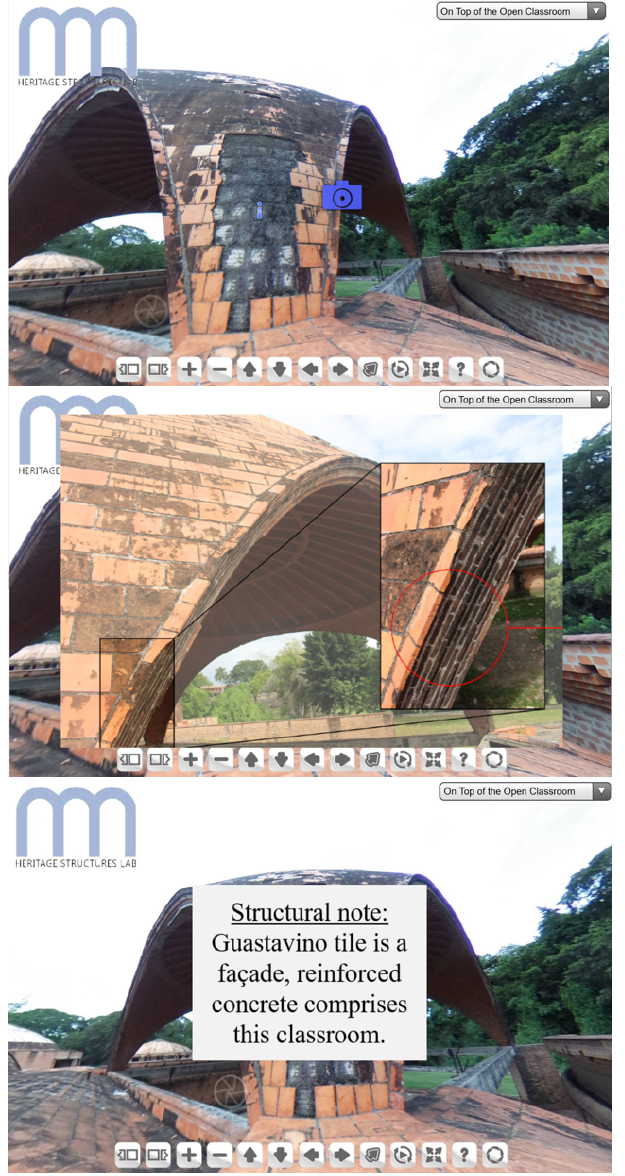
Figure 8. Illustration of hotspots in VT/IM environment. The top figure depicts the icons in the environment; the subsequent figures illustrate hotspot capabilites.